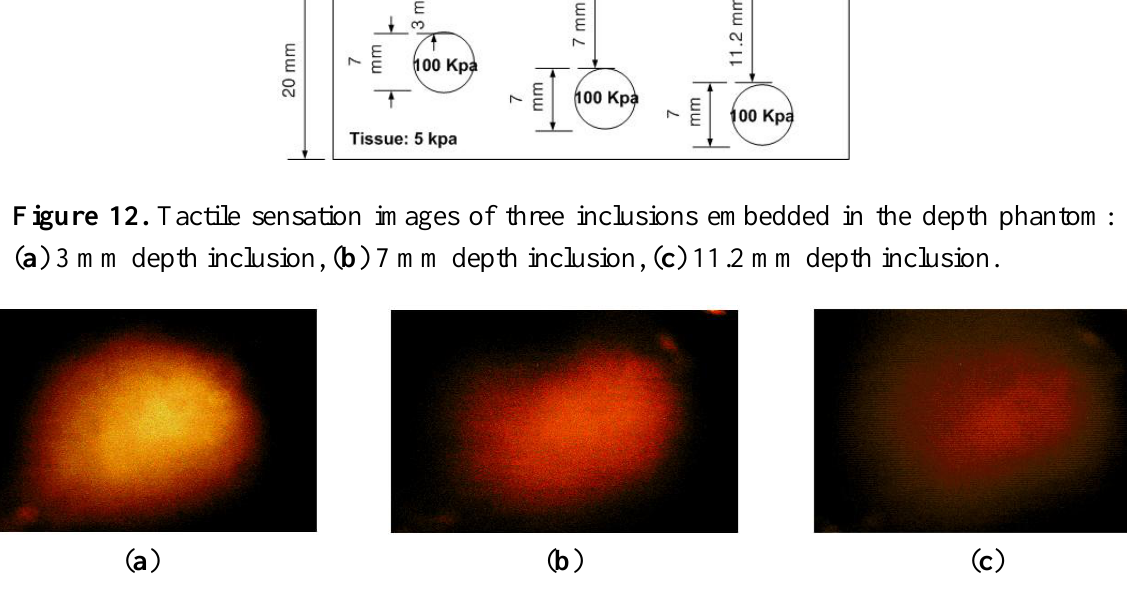
Figure 13. Error bar chart of the estimated relative depth of each